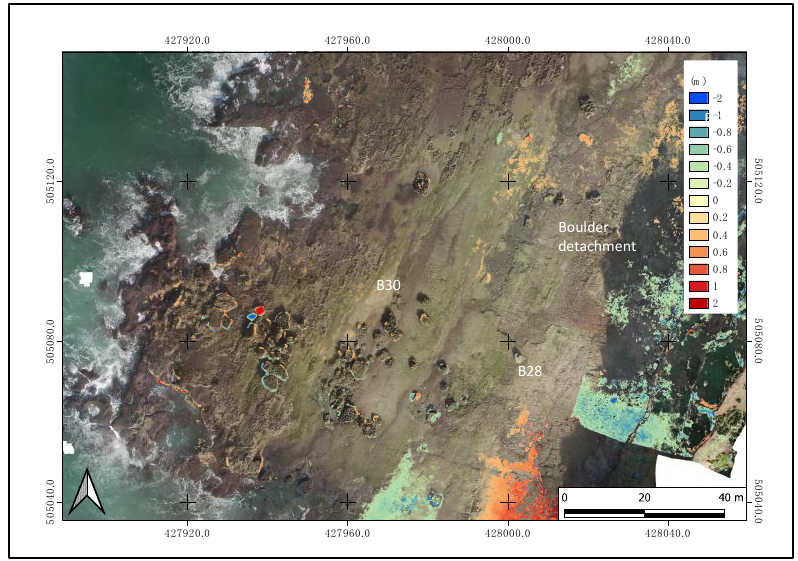
Figure 10. Orthophoto generated from the December 2019 UAV survey, showing the spatial distri- bution of three boulders affected by the December storm (B28, B29, and B30). An incipient boulder detachment is also visible in the central sector of the rock platform.